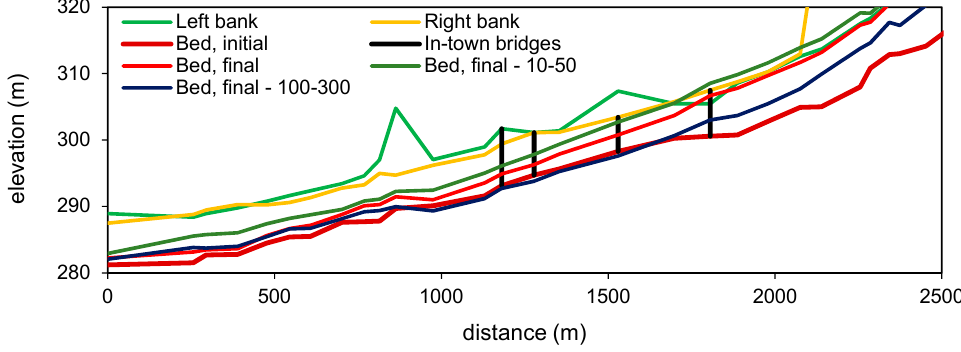
Figure 14. Model of the design flood scenario: sensitivity to the sediment size (sizes for the downstream and upstream homogeneous reaches indicated in mm in the legend), considering that the benchmark model is for 50–150 mm.